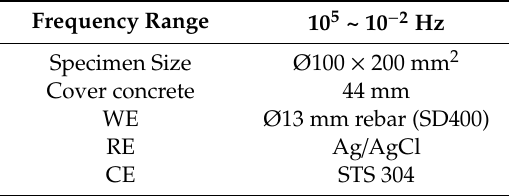
Table 4. Experimental overview of EIS experiment.